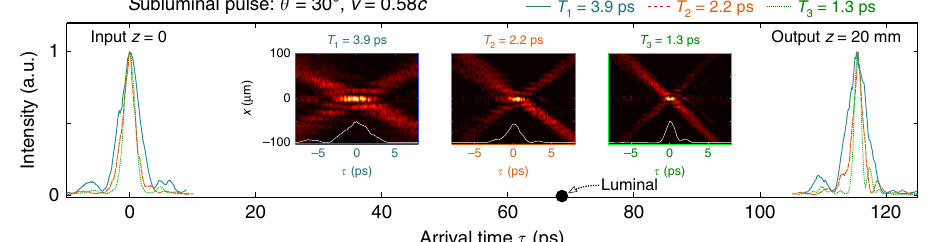
Fig. 5 Increase in the DBP with reduced pulse width (increased temporal spectral bandwidth). We plot the on-axis intensity pro fi le I (0, z , τ ) of three ST wave packets of different widths ( T 1 ≈ 3.9 ps, T 2 ≈ 2.2 ps, and T 3 ≈ 1.3 ps) but identical group velocity ( e v ¼ 0 : 58 c ) recorded at two detector positions: z = 0 (left) and z = 20 mm (right). The pulses undergo the same delay of ~115 ps with minimal pulse reshaping. Insets are the spatio-temporal pro fi les of the wave packets.